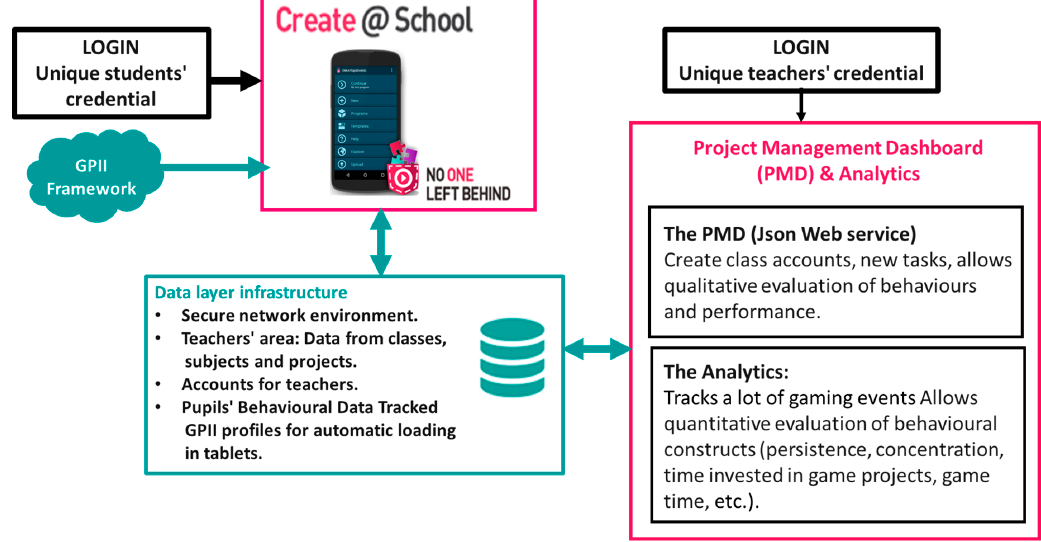
Figure 1. High level view of the No One Left Behind (NOLB) technical framework.